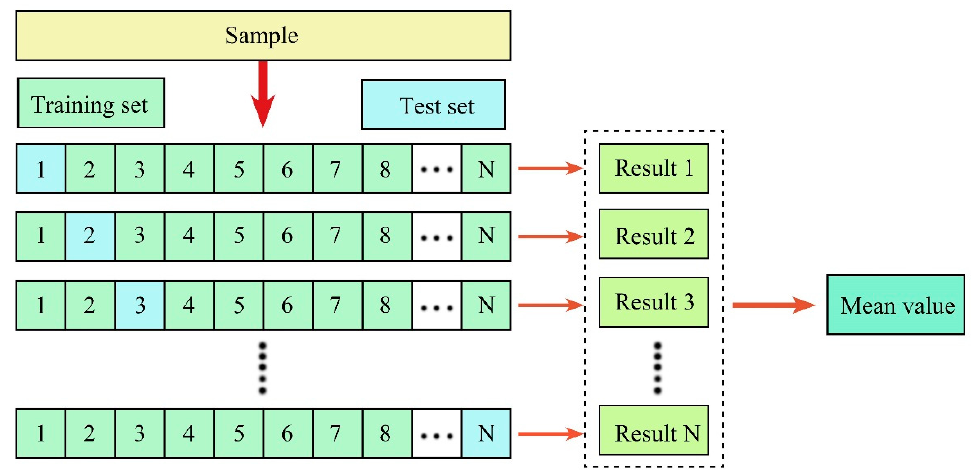
Figure 8. Diagram of leave-one-out cross-validation. There are N samples; each sample is used as a test sample, and the other N-1 samples are used as training samples. This yields N classifiers and N test results, and the average of these N results is used to measure the performance of the model.